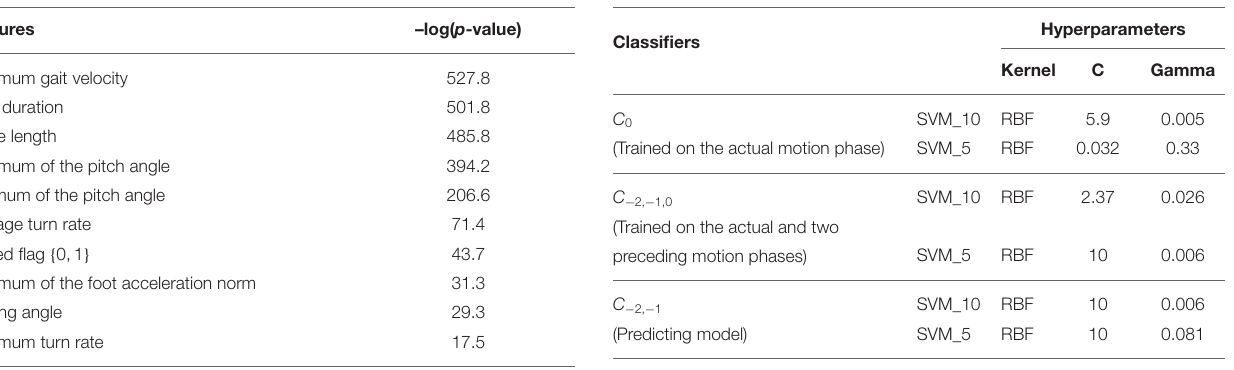
TABLE 2 | Feature ranking based on the chi-square test. TABLE 3 | SVM